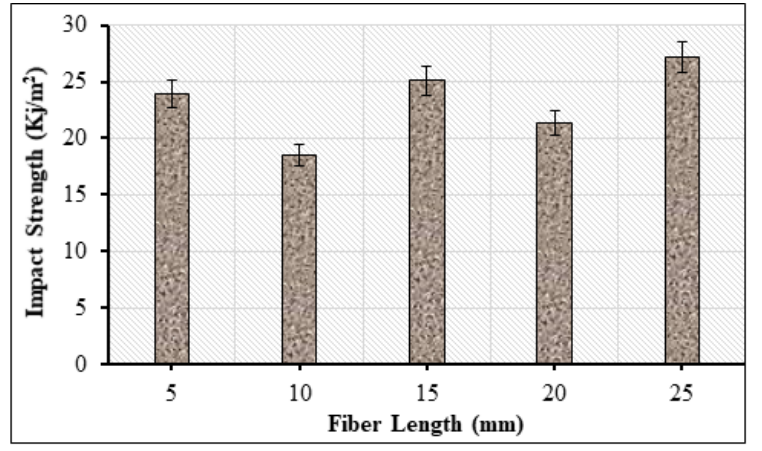
Figure 9. Impact strength vs. fiber length.